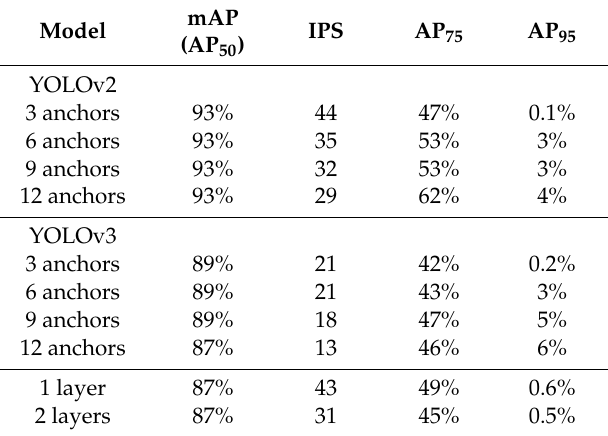
Table 3. Comparison on anchors and